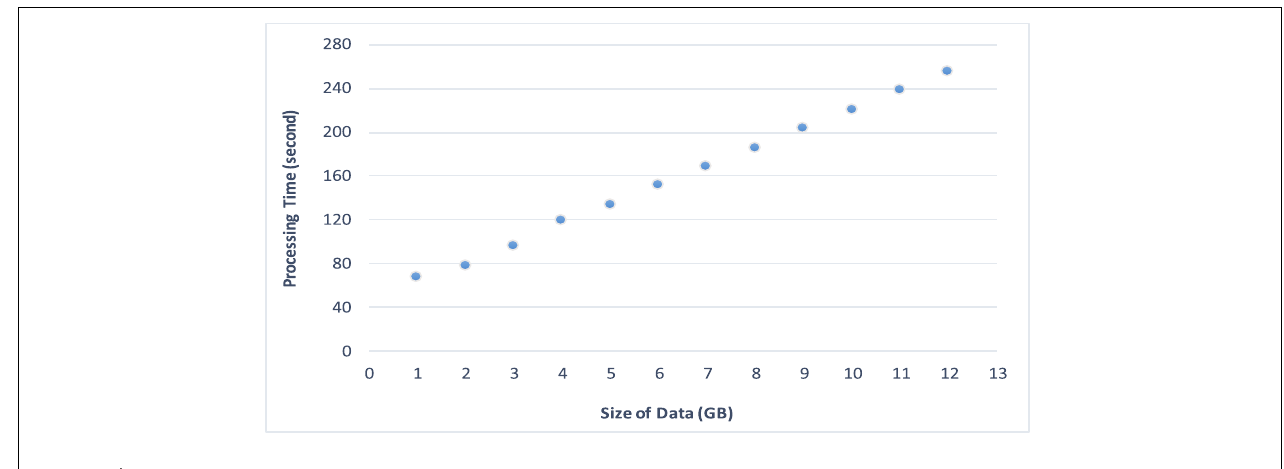
FIGURE 6 | Processing time.